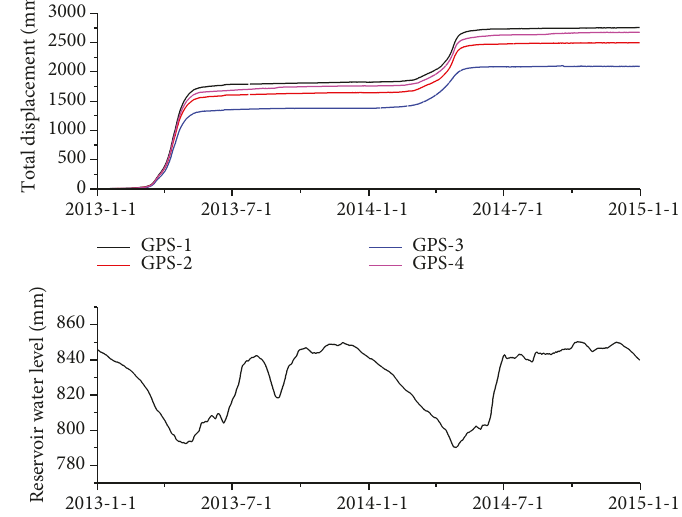
Figure 11: Surface displacements by GPS measuring stations versus reservoir water level fl uctuations.